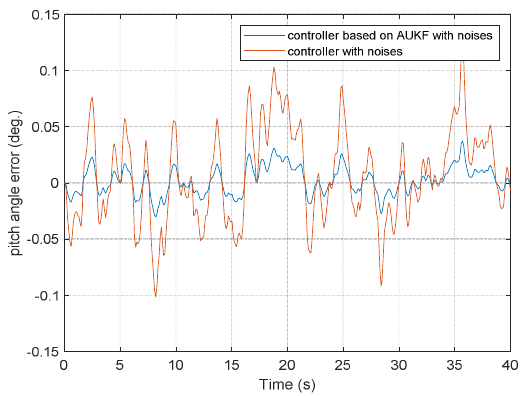
Fig . 17. Estimation the pitch angle using controller based on AUKF